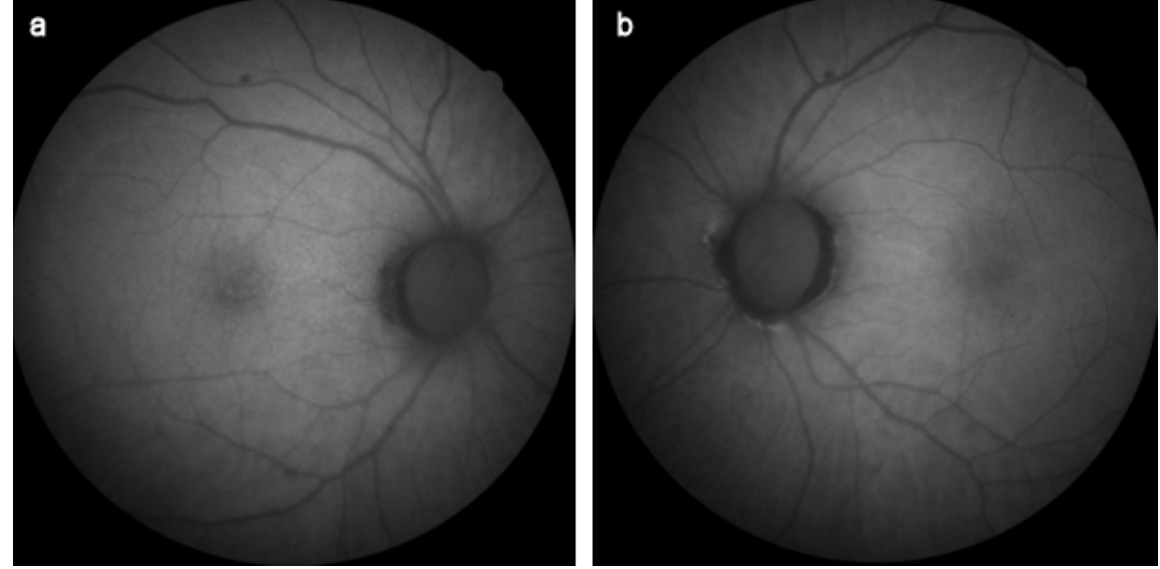
Figure 2: FAF images at the time of diagnosis image of the left